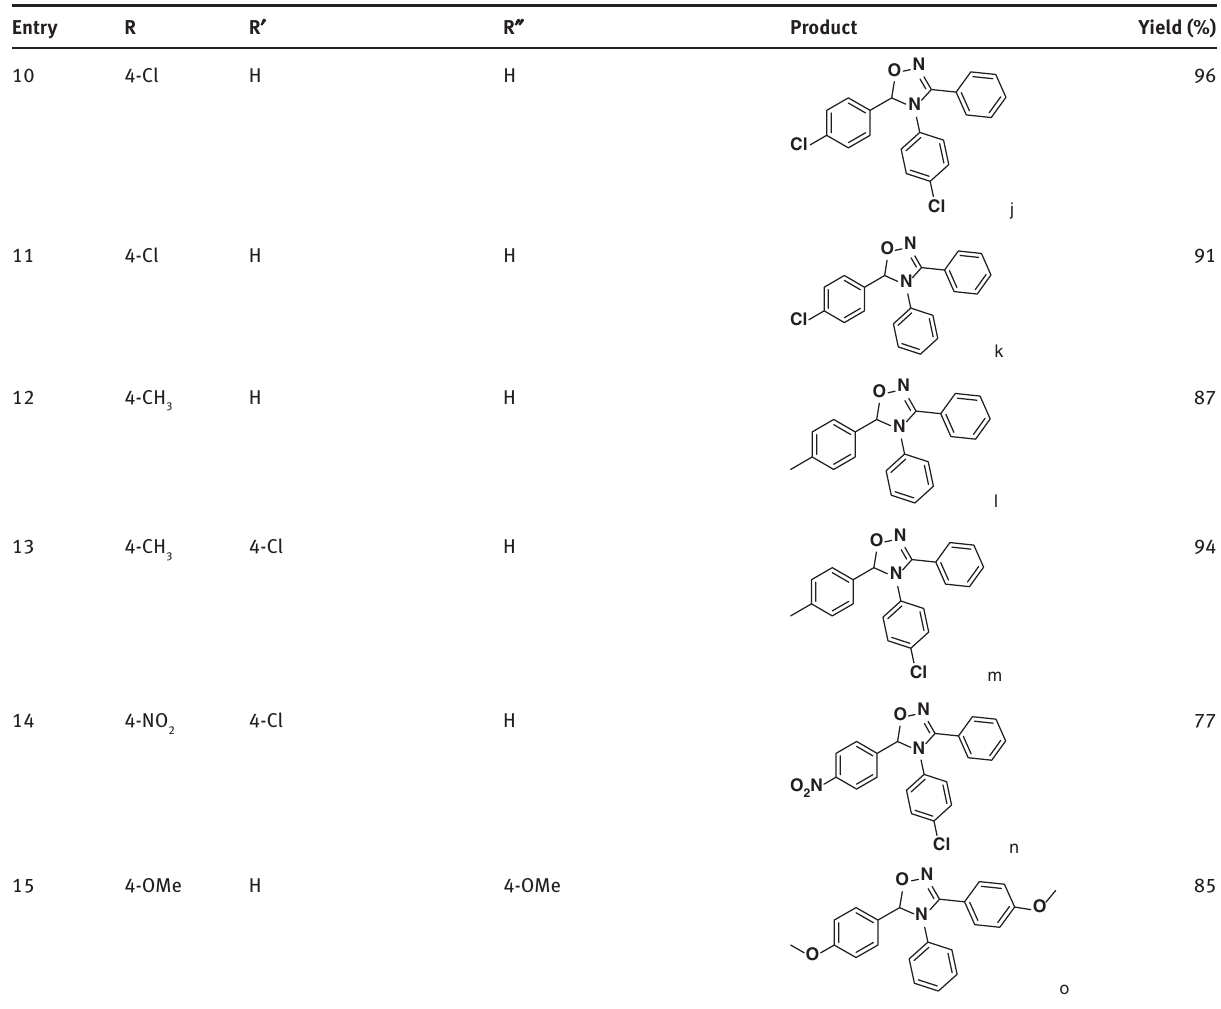
Figure 1. Peaks at 2 θ = 20.9 ° , 26.8 ° , 50.3 ° and 61 ° are attrib- uted to the presence of silica [SiO ] and at 12.4 ° , 19.8 ° and 2 27.8 ° owing to palygorskite. Montmorillonite shows dif- fraction peak at 2 θ = 8.9 ° (d 001 reflection), 19.7 ° , 32.1 °